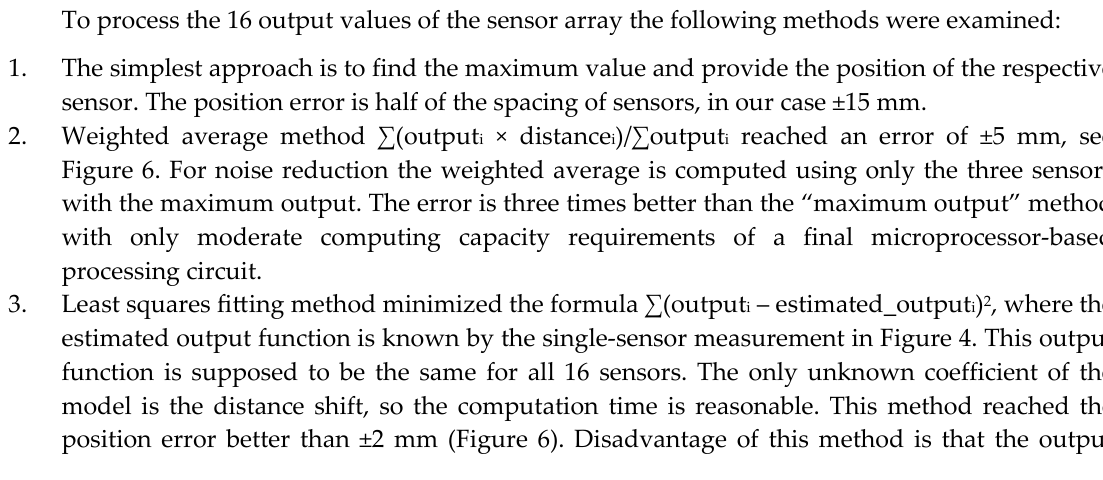
Figure 6. For noise reduction the weighted average is computed using only the three sensors with the maximum output. The error is three times better than the “maximum output”